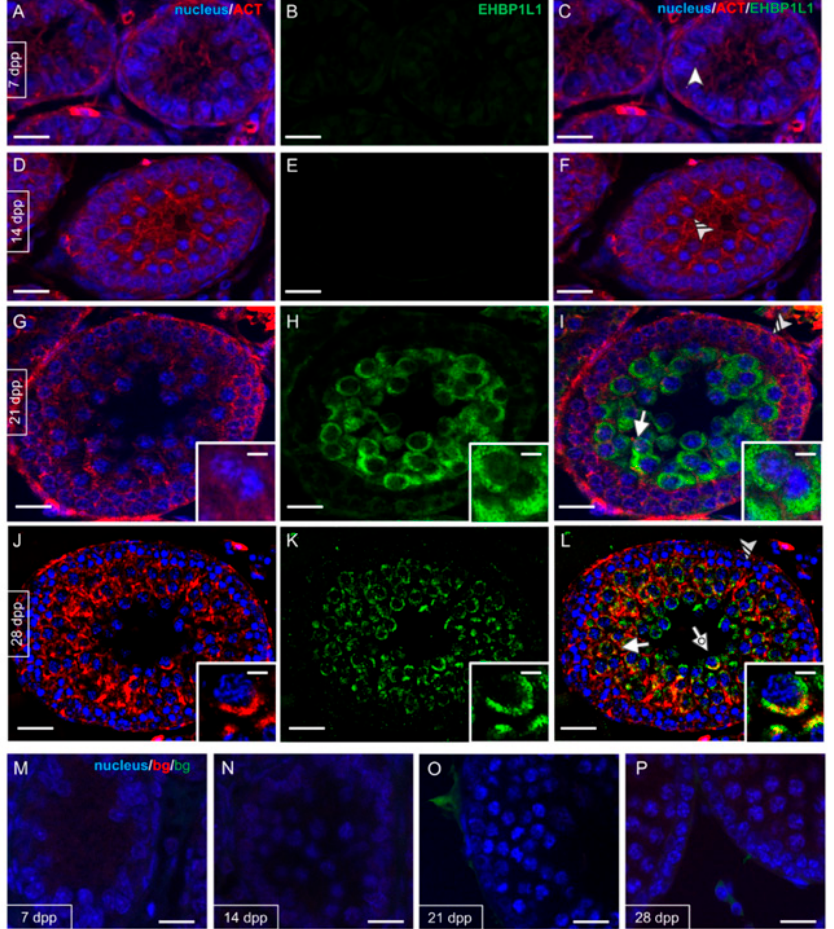
Figure 6. Co-localization of EHBP1L1 and ACTIN during the first wave of rat spermatogenesis (7– 28 dpp). ( A , D , G , J ) DAPI-fluorescent nuclear staining (blue) and ACTIN staining (red). ( B , E , H , K ) EHBP1L1 fluorescence (green). ( C , F , I , L ) Merged fluorescent channels (blue/red/green). The intermediate yellow–orange tint indicates EHBP1L1 and ACTIN co-localization. ( A – C ) 7 dpp testis; ( D – F ) 14 dpp; ( G – I ) 21 dpp; ( J – L) 28 dpp. ( M – P ) Negative controls for the same time points, obtained by omitting the primary antibodies. Scale bars represent 20 μ m, except for the insets, where they represent 10 μ m. Arrowhead: gonocytes; striped arrowhead: SPG; arrow: I SPC; dotted arrow: rSPT. Actin was detectable in gonocytes (arrowhead; Figure 6C) and SPG (striped arrow- head; Figure 6F) and then in meiotic SPC (arrow; Figure 6I and inset). At 28 dpp, the co-